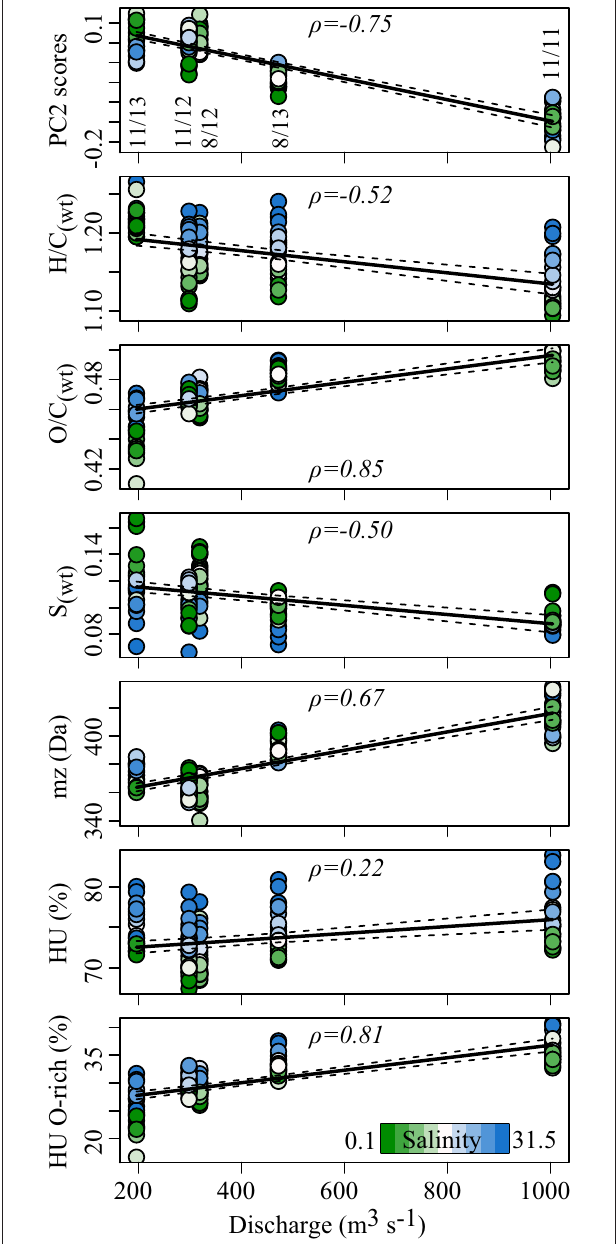
FIGURE 4 | Characteristics of DOM molecular formulae vs. discharge. All samples per cruise are plotted and colored according to salinity. Cruise is marked in the top panel as MM/YY. Solid lines represent linear regression, dashed lines denote standard error. Spearman rank correlations for each parameter vs. discharge are given ( ρ ). Significance of correlations is p < 0.001, except for HU where p < 0.05. HU, highly unsaturated compounds; PC2 scores are taken from Figure 3